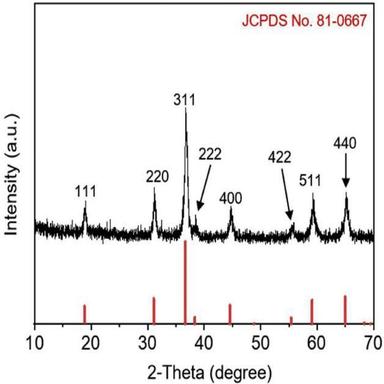
X-ray diffraction pattern of MgCo2O4-NWs isolated from the skeleton of NF.